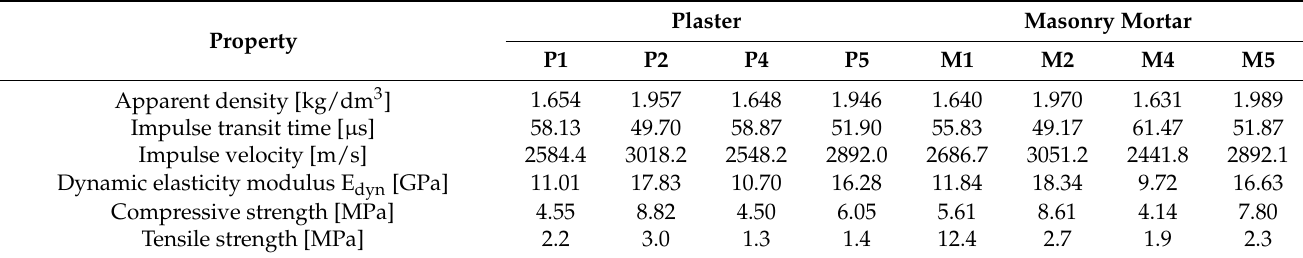
Figure 10. Dynamic elasticity modulus and compressive strength of plasters ( a , c ) and masonry mortars ( b , d ). Table 10. Strength and elasticity modulus of